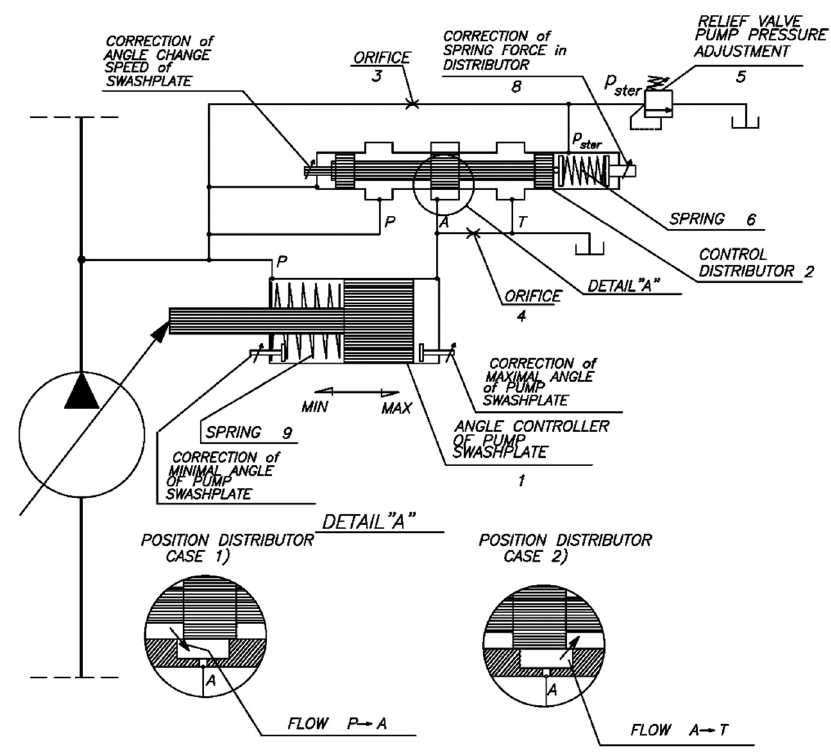
Figure 2. Idea diagram of a pressure constant pump regulator DP. Source: own preparation based on Bosch Rexroth catalogue